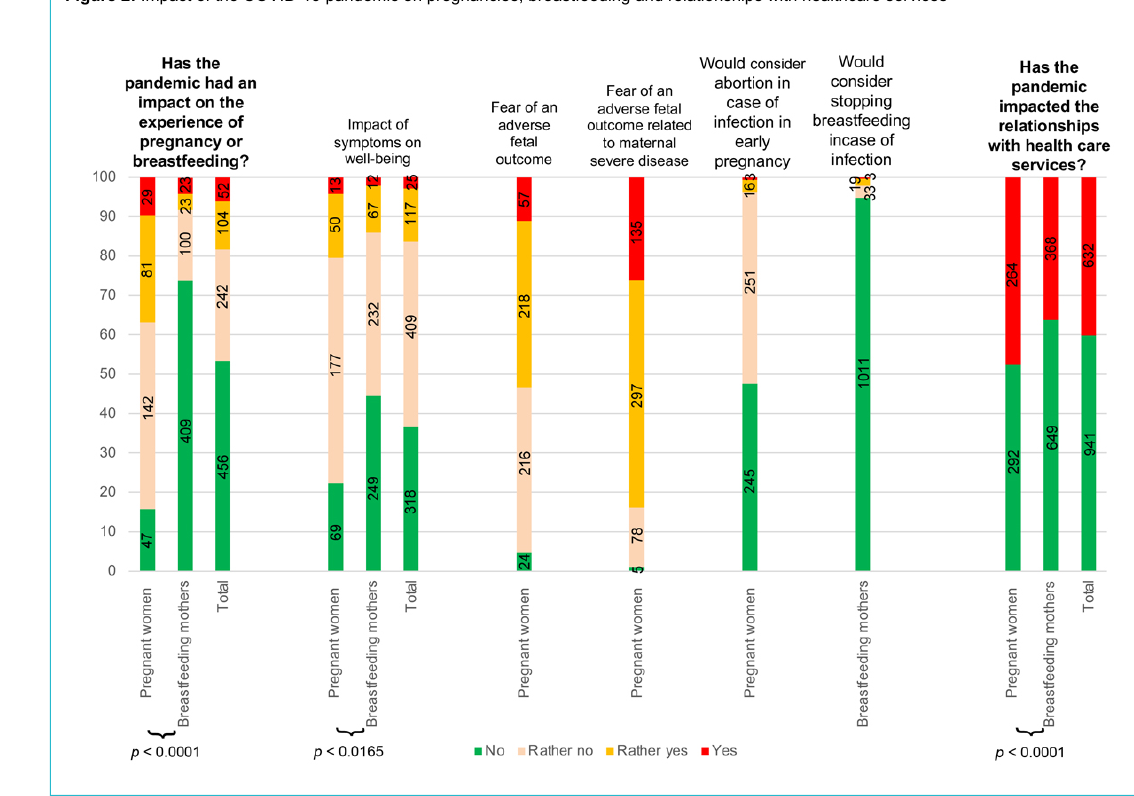
Figure 2: Impact of the COVID-19 pandemic on pregnancies, breastfeeding and relationships with healthcare